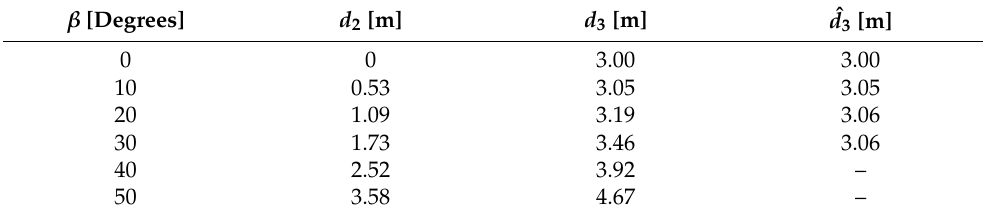
Table 2. Real distance ( d 3 ) and distance estimate ( ˆ d 3 ), obtained varying the incidence angle β in the range [ 0 ◦ ,50 ◦ ] , with a 10 ◦ step. The IoT node is placed at 3 m distance (in the perpendicular direction) from the